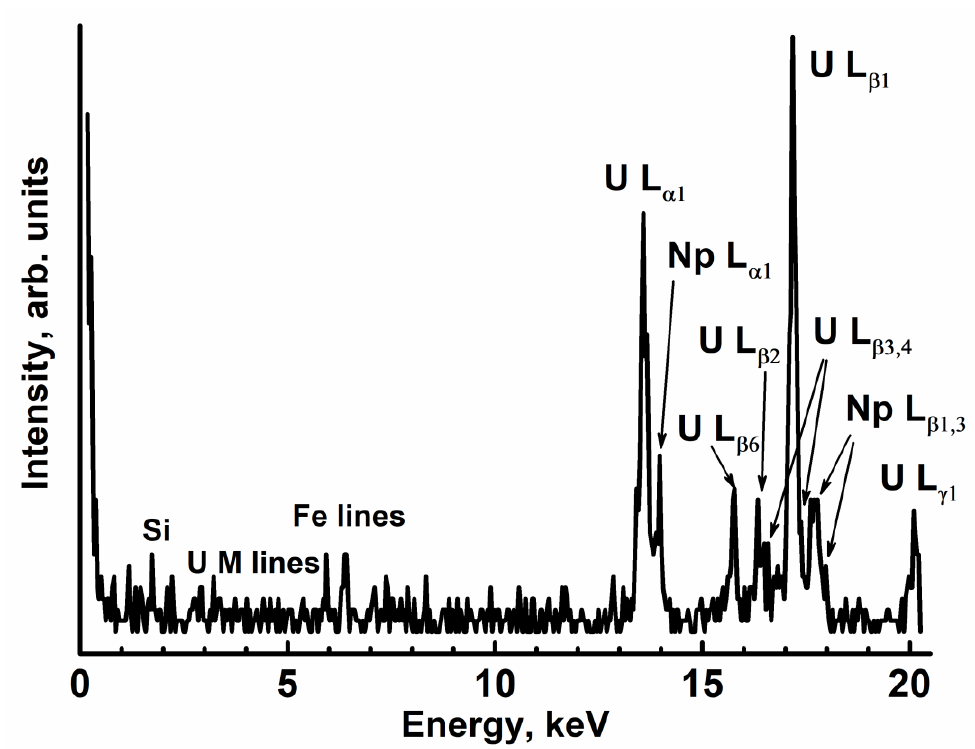
Figure 3. Autoemission spectrum of the sample R1 with tentative assignment of the peaks. The energy axis is binned down to 512 channels to improve statistics. Main peaks are assigned to most plausible transitions.